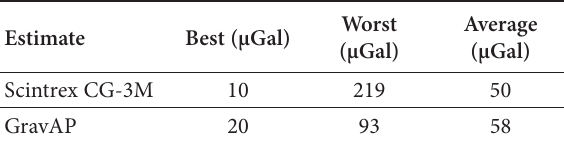
Table 3. Accuracy estimate of the gravimetric measurement